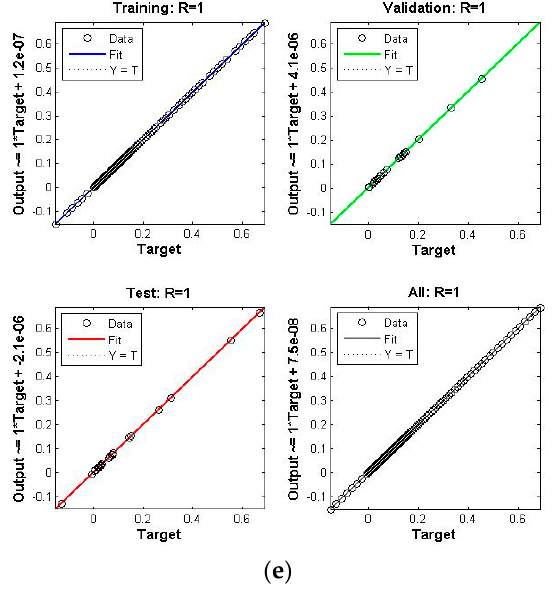
Figure 8. Scenario V Case I of TD-PNFM. ( a ) MSE Results: Scenario V Case I; ( b ) Transition state: Scenario V Case I; ( c ) Fitness: Scenario V Case I; ( d ) Error Histogram: Scenario V Case I; ( e )regression: Scenario V Case I.